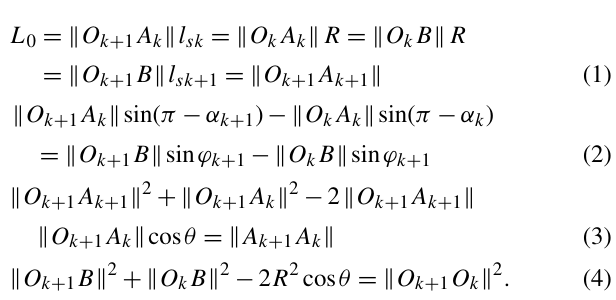
Figure 4. The internal drive system of the mechanism.